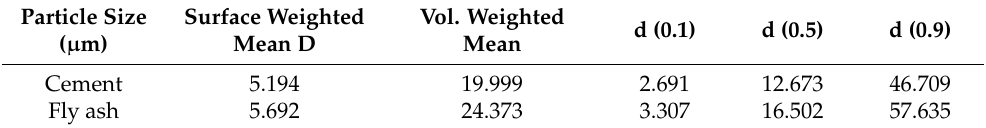
Table 3. Particle size distribution of cement and fly ash. Table 4. Properties of RCA and RFA.